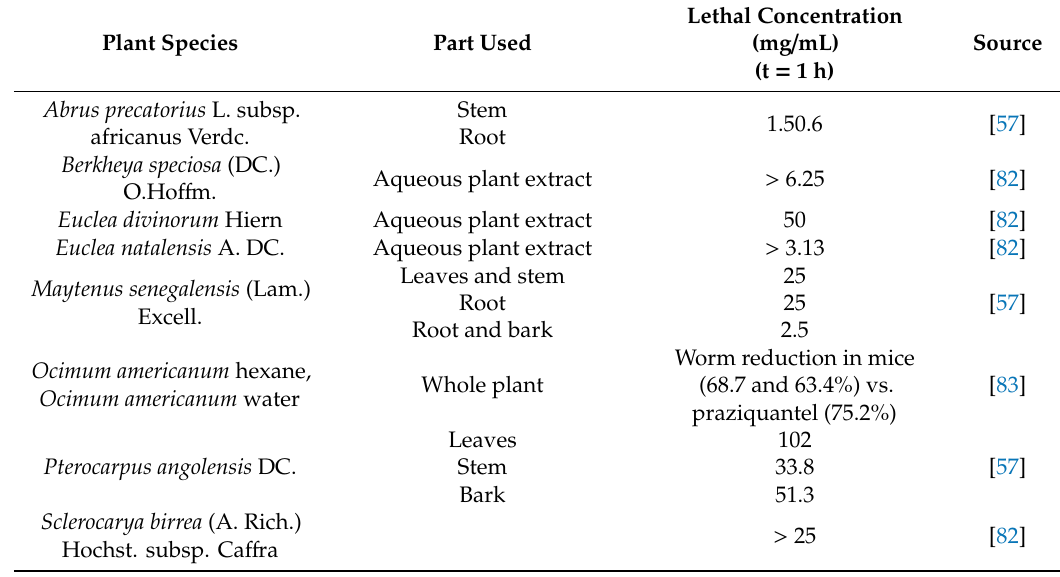
Table 3. In vitro studies of traditionally employed plant species against Schistosoma mansoni. Plant Species Part Used